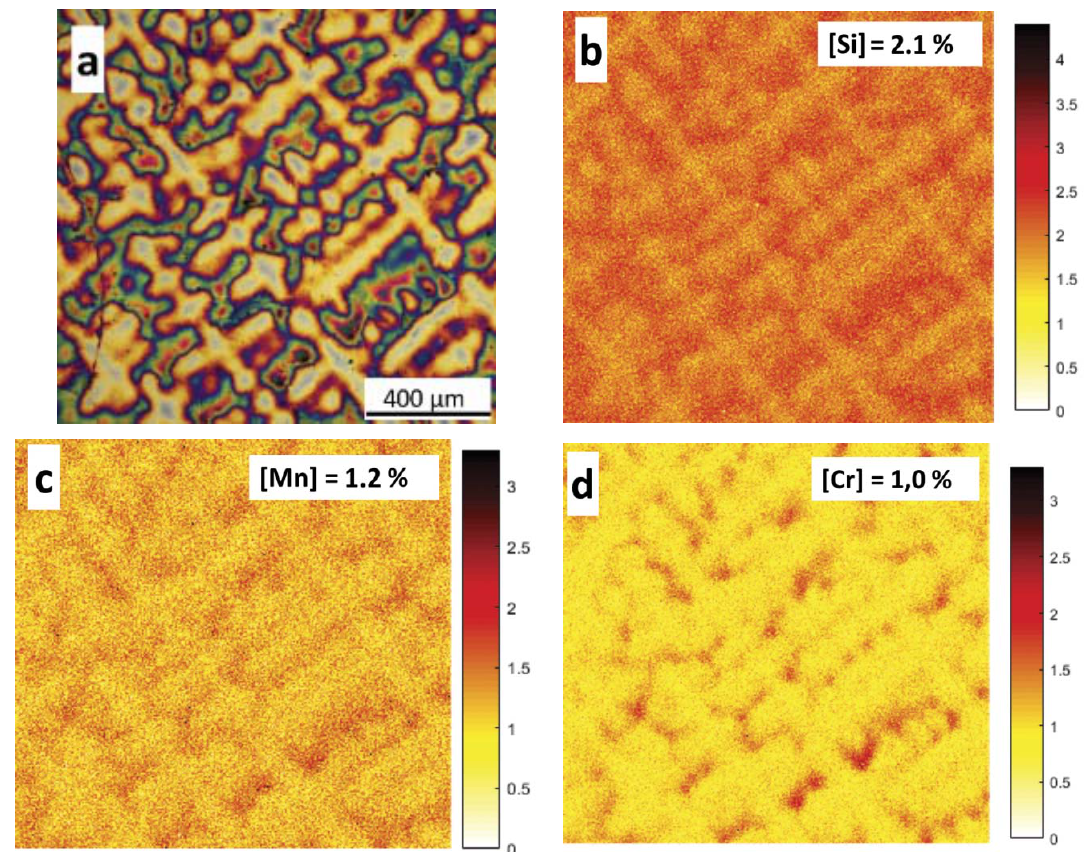
Figure 4. Solidification structure. Image ( a ) is a color micrograph corresponding to the zone under study; ( b ), ( c ) and ( d ) are the EPMA maps of the same zone for Si, Mn and Cr, respectively. Comparing the color micrograph with the EPMA maps, it is clear that for all the elements, areas with the highest concentration values (darker color) match with interdendritic ones (or LTF zones), while areas with lowest concentration values match with dendritic ones (or FTF zones ‐ yellow color).